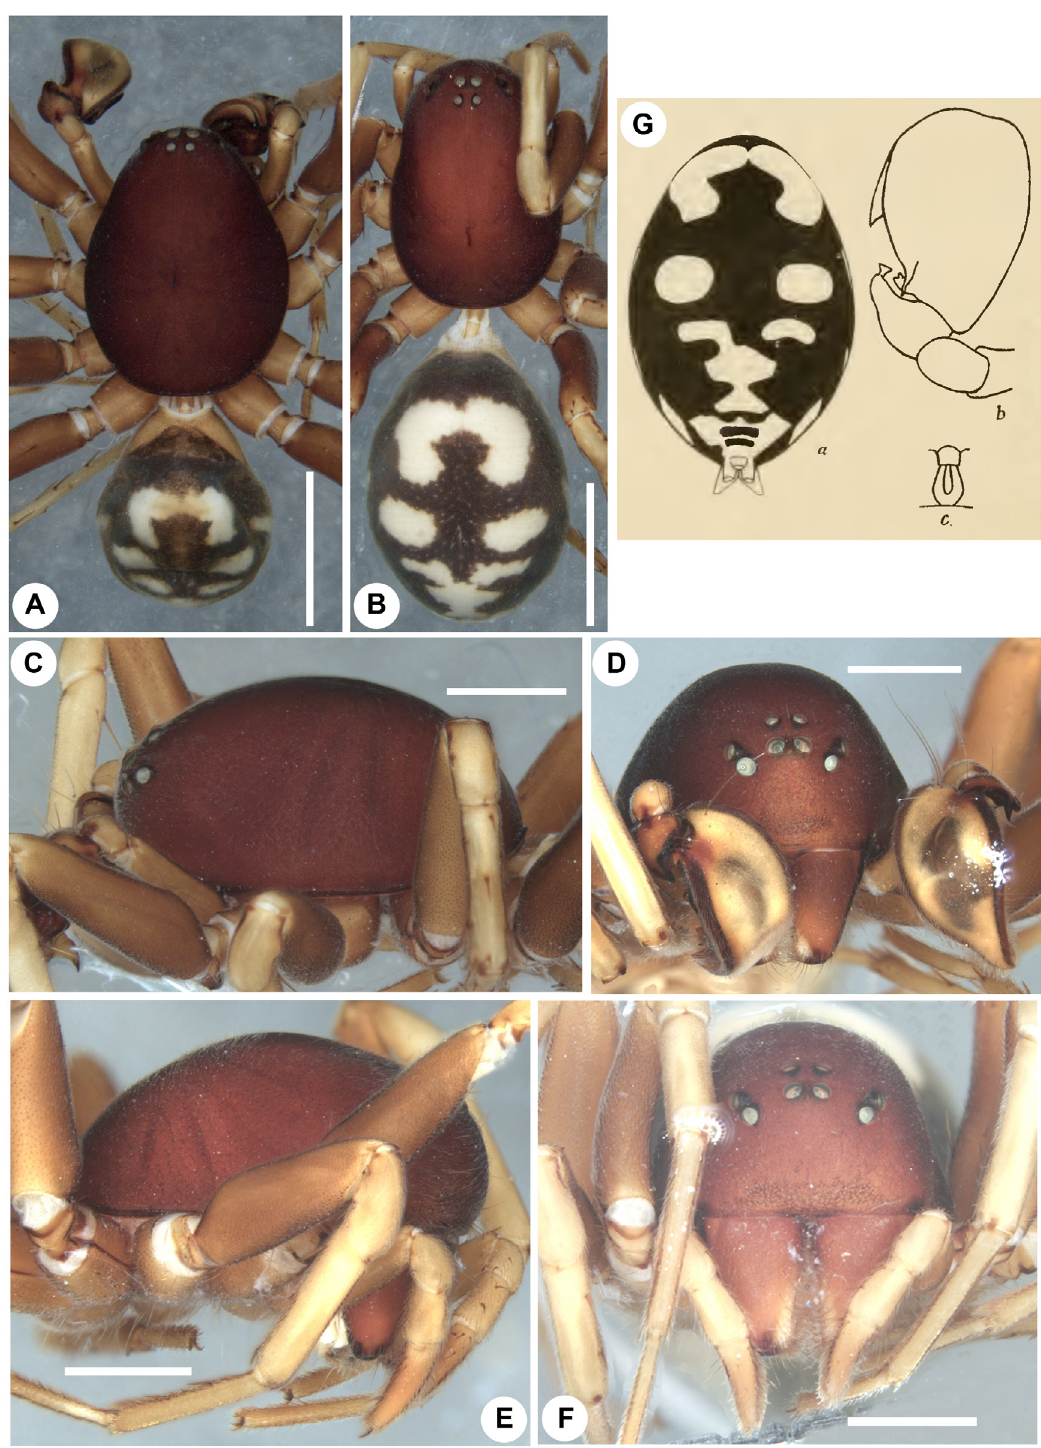
Fig. 1. Laminion birenifer (Gravely, 1921) gen. et comb. nov., ♂♀, syntypes of Storena birenifer Gravely, 1921. A , C–D . ♂ (NZC-ZSI-2914/H2). A . Habitus, dorsal view. C . Prosoma, retrolateral view. D . Same, frontal view. B , E–F . ♀ (NZC-ZSI-2914/H2). B . Habitus, dorsal view. E . Prosoma, prolateral view. F . Same, frontal view. G . Original illustrations of S. birenifer adapted from Gravely (1921). Scale bars: A–B = 2 mm; C–F = 1